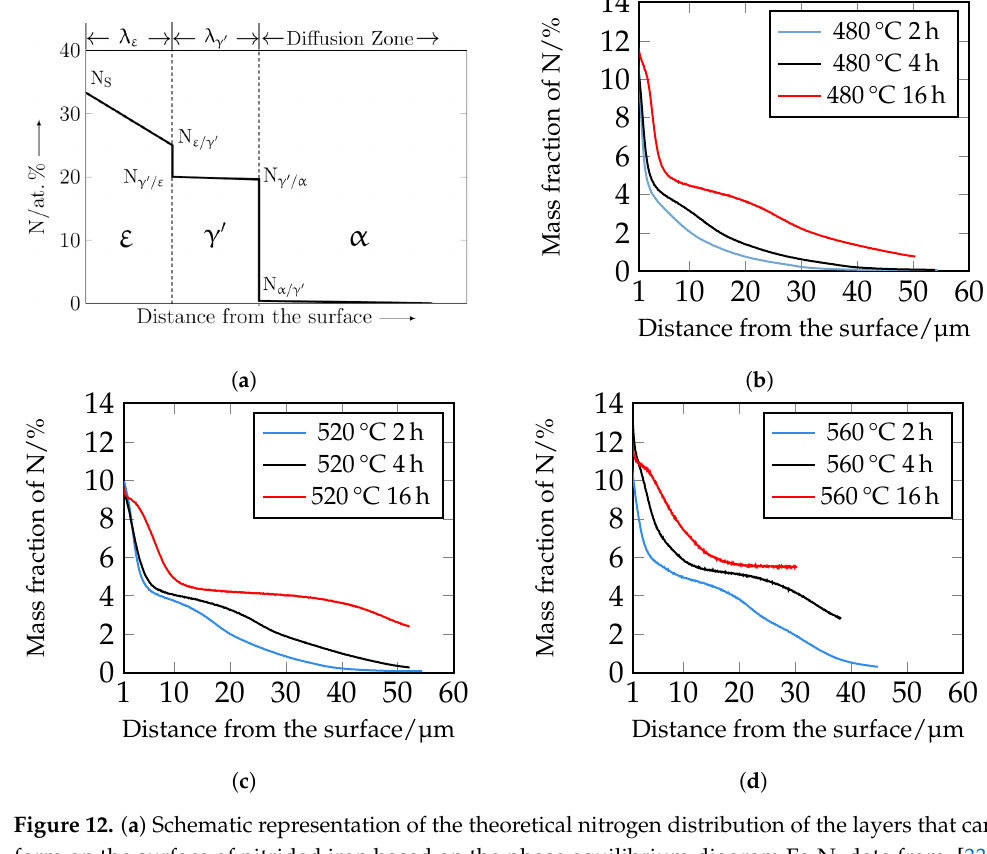
Figure 12. ( a ) Schematic representation of the theoretical nitrogen distribution of the layers that can form on the surface of nitrided iron based on the phase equilibrium diagram Fe-N, data from [33]. Concentration profiles of nitrogen plasma nitrided with different durations ( b ) at 520°C, ( c ) at 480°C and ( d ) at